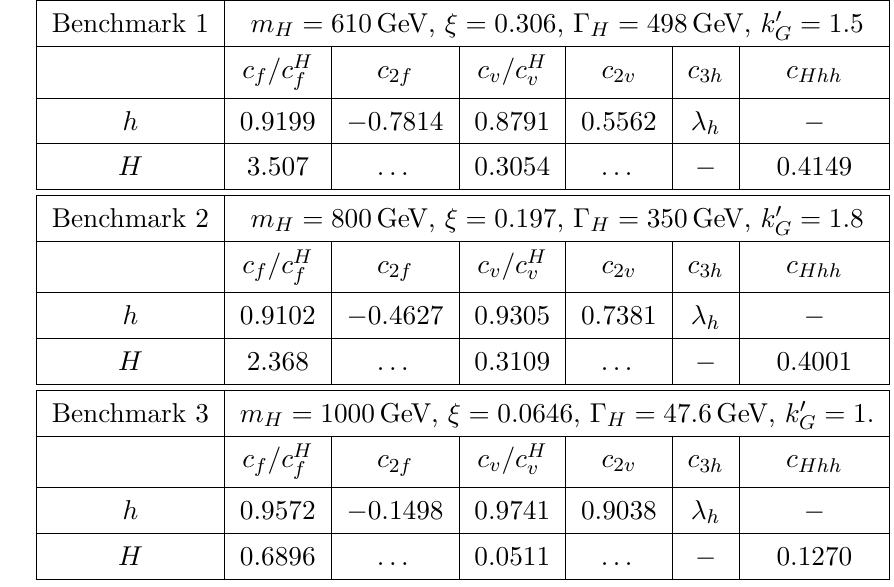
Table 5 . Couplings of the Higgs h and of the heavier state H , for 3 benchmark points. The parameter k 0 characterises the coupling of the heavy resonance to the gauge bosons (see ref. [39] G for more